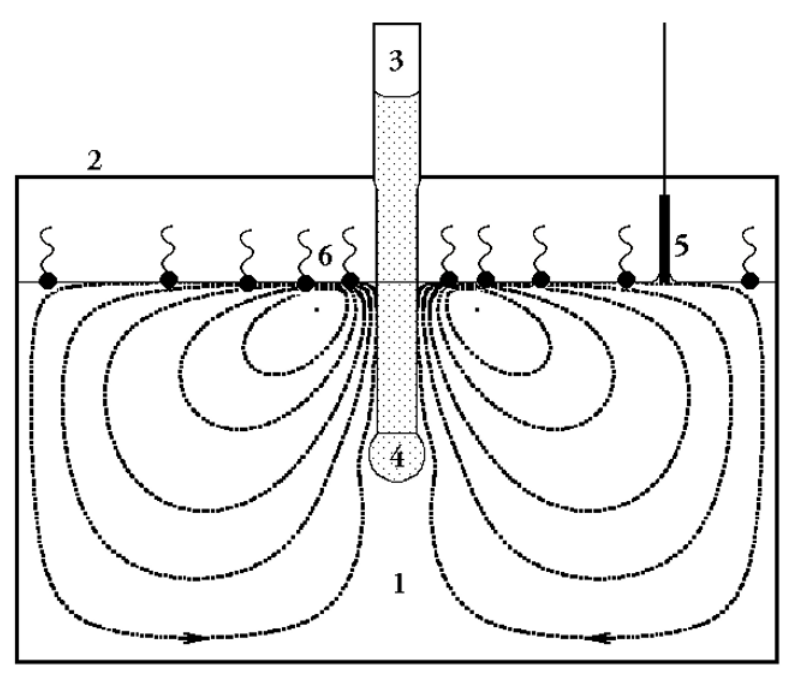
Figure 2. Schematic representation of the system producing spontaneous oscillations: 1 – cylindrical vessel filled with water, 2 – covering plate, 3 – capillary, 4 – surfactant droplet, 5 – Wilhelmy plate, 6 – air/water interface with adsorbed